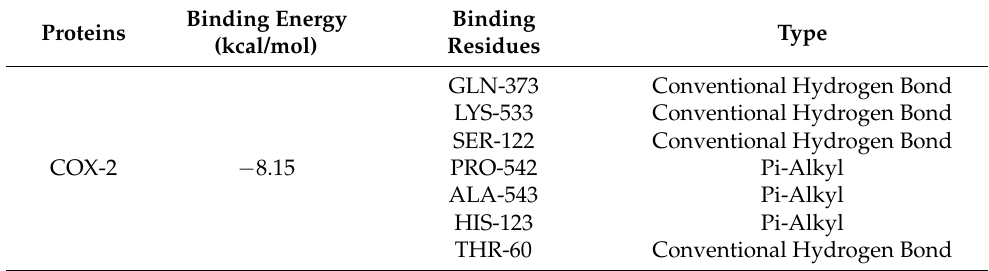
Table 7. Intermolecular interactions between rosmarinic acid and COX-2, NF- κ B, AKT, and